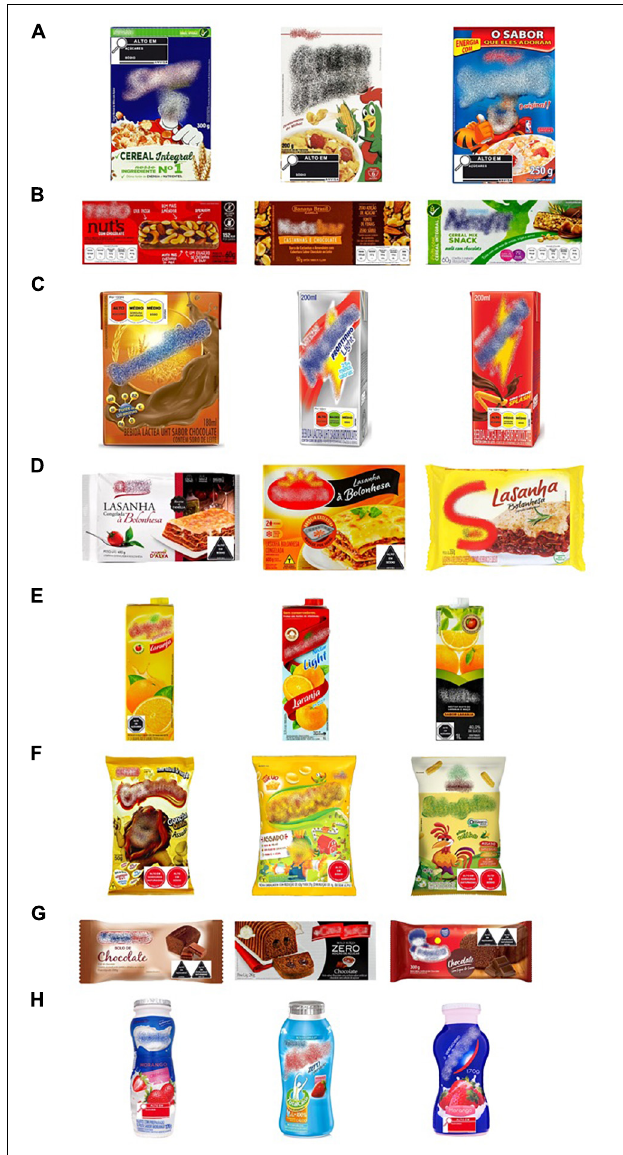
FIGURE 2 | Example of some of the packages used in the study: (A) breakfast cereal, (B) cereal bar, (C) chocolate flavored milk, (D) frozen lasagne, (E) orange nectar, (F) savory snack, (G) sponge cake, (H)